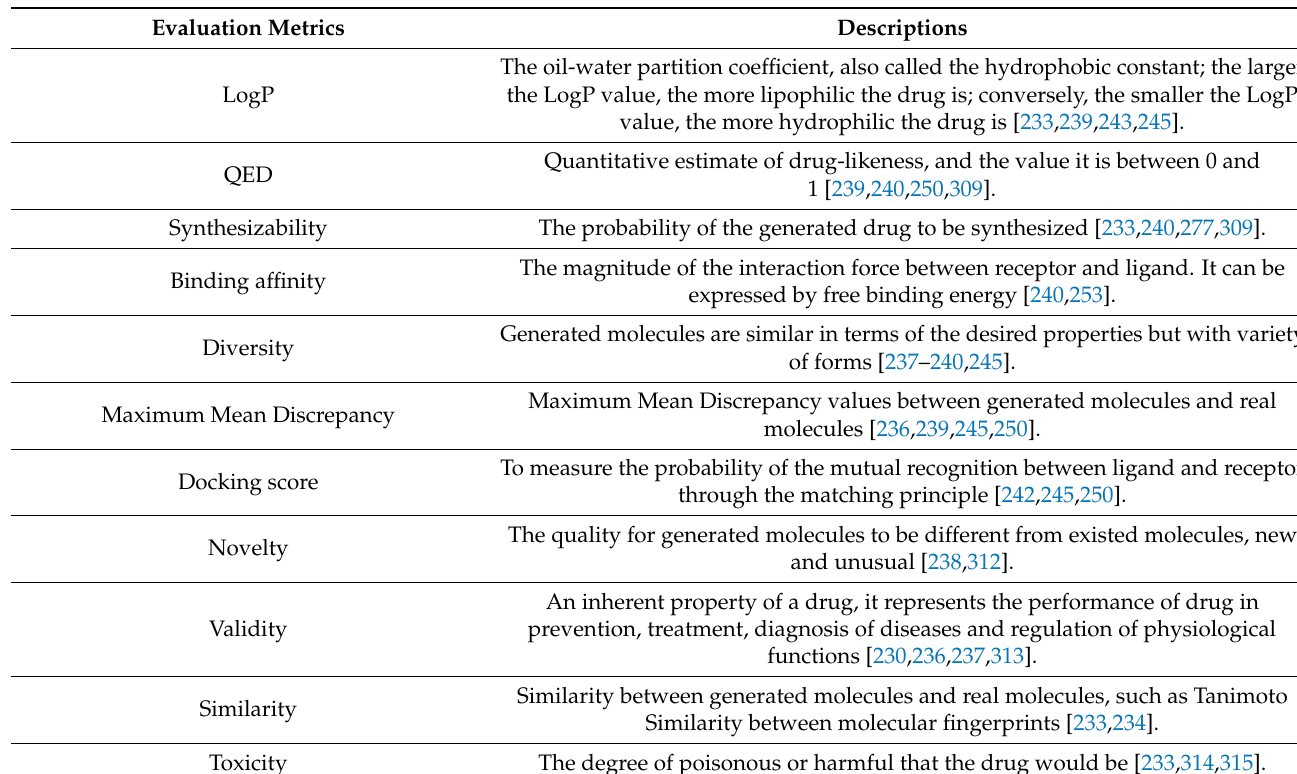
Table 3. Evaluation metrics in drug